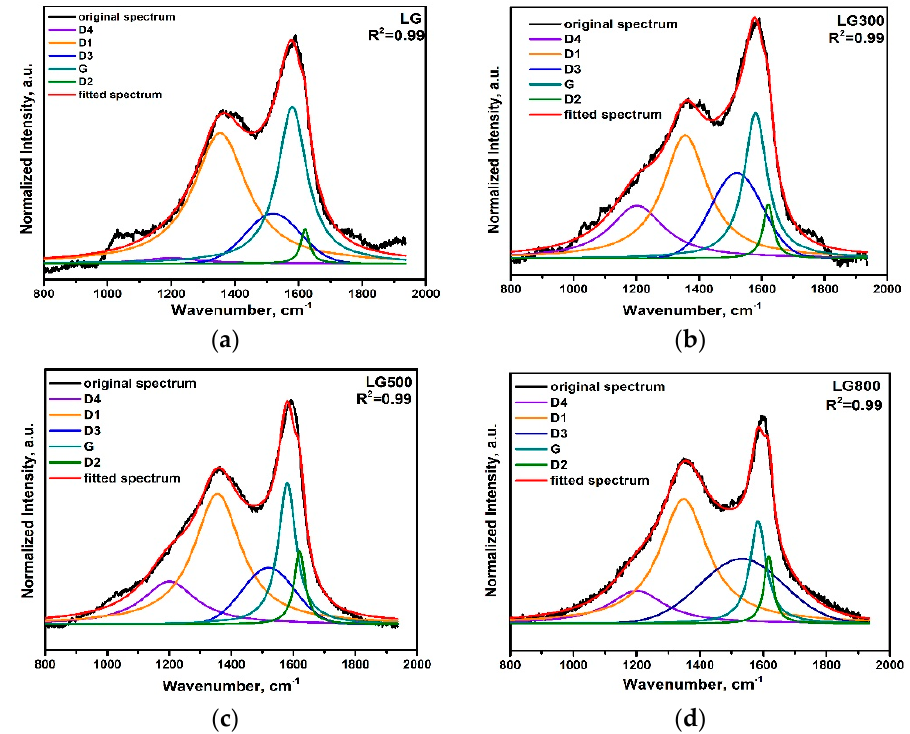
Figure 3. Curve fitting of Raman spectra for raw lignite and as-produced chars.